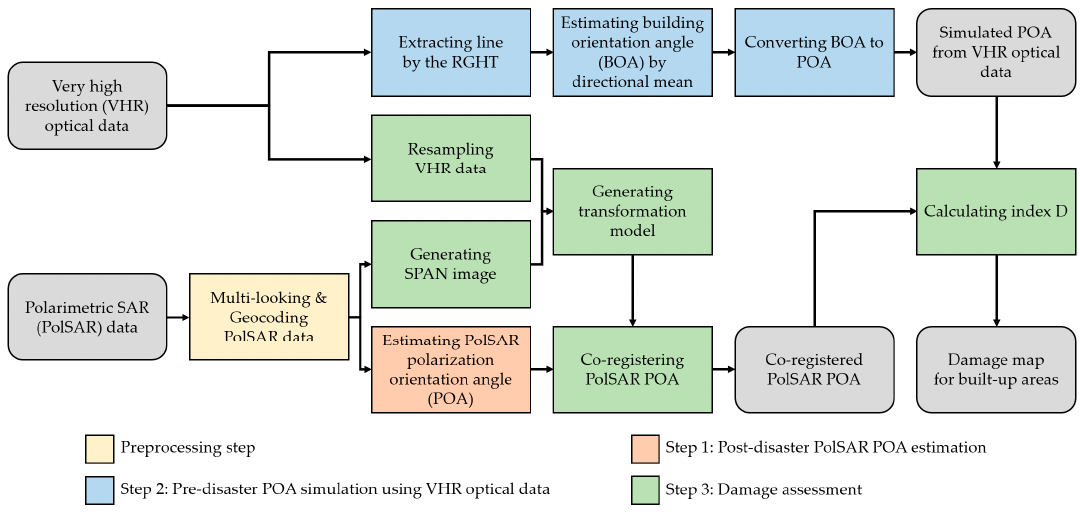
Figure 2. Block diagram of the proposed method. The regular grid-based Hough transform (RGHT) is the line extraction method proposed by Yeom and Kim [27]. A SPAN image represents the total scattering power of PolSAR data as Equation (9). An index D is the damage level indicator proposed in this article as Equation (13).